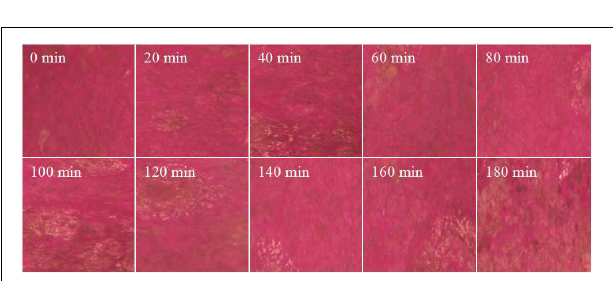
FIGURE 10 | Rhodamine B spots on the surface of EBFS-1180 ceramic without light